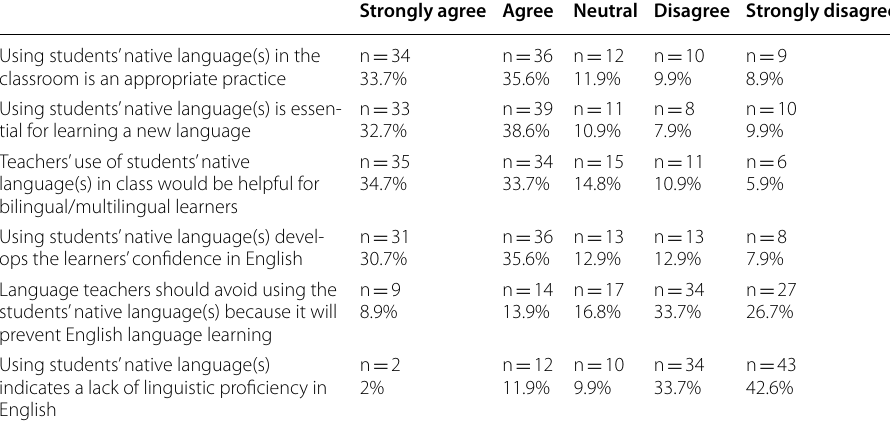
Table 2 Teachers’ general attitudes towards pedagogical translanguaging Strongly agree Agree Neutral Disagree Strongly